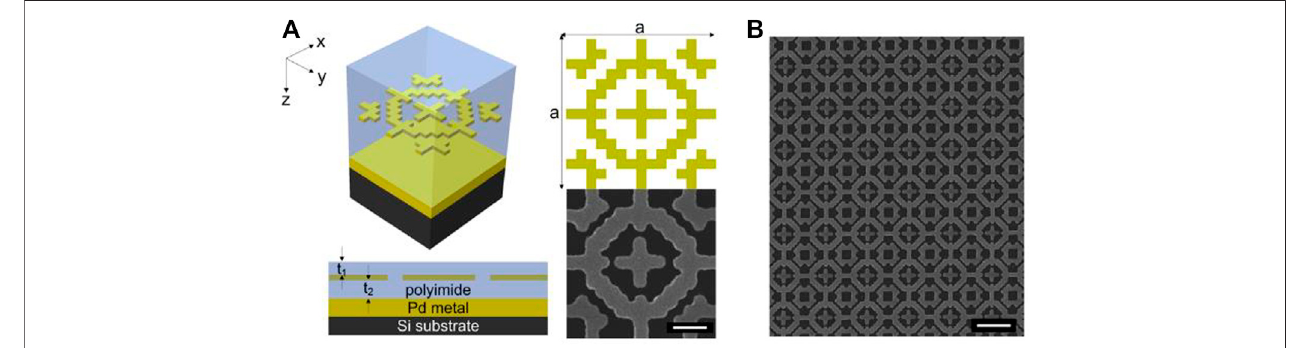
FIGURE14|(A) Schematicoftheunitcellbroadbandabsorber, (B) Nanofabricatedimageofthemetamaterialabsorber.Reprinted(adapted)withpermissionfrom [108]. Copyright (2014), American Chemical Society.